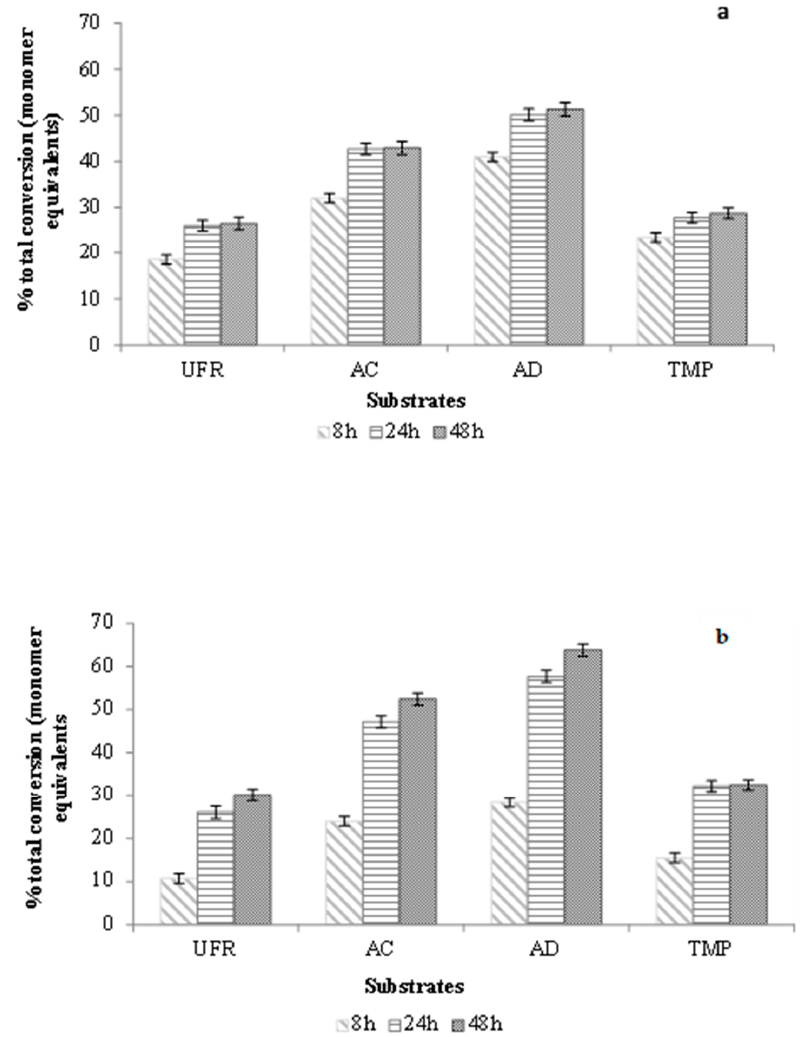
Figure 4. Quantitative estimation of products from different SSL-AcGGM preparations and TMP-AcGGM ( a ) Tr Man5A ( b ) Viscozyme L. All the substrates were used at an initial concentration of 100 mg/mL of GGM and the enzyme concentration for both Tr Man5A and Viscozyme L was at 0.1 mg/mL. The enzymatic hydrolysis was carried out over 48 h of incubation at 40 °C and pH 5.0. The mono- and oligo-saccharide analysis was carried out using HPAEC-PAD with CarboPac PA20 and PA200 columns, respectively. The quantities of quantifiable monosaccharides and oligosaccharides after enzymatic hydrolysis was reported as % conversion (sum of produced oligosaccharides as monomer equivalents and mono-saccharides/total polymeric galactosyl, glucosyl, and mannosyl content of the original substrate in monomer equivalents). The values are based on the data pre- sented in Figures S4 and S5 with numeric values given in Tables S2 and S3 . It is an interesting observation that the rate and the total hydrolysis of the SSL-Ac- GGM preparations decreased with increased content of lignin (Figure 4, Table 1). Several factors may have influenced the enzymatic bioconversion. Enzyme inhibition by lignin is a plausible contributing factor. Notably, lignin and lignin-derived compounds from wood processing have been shown to inhibit cellulases [28,30]. Remarkably, the hydrolysis of